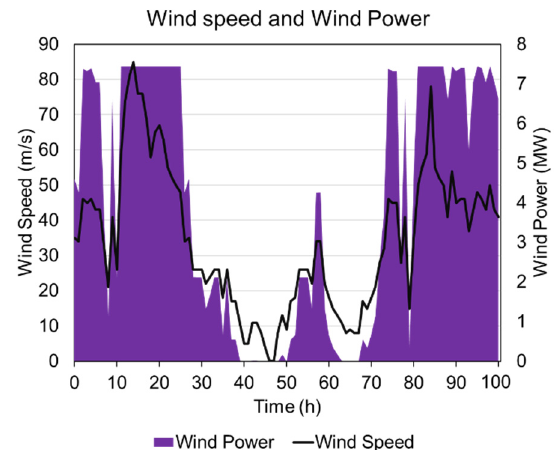
Figure 5. Wind speed and wind power change with time on the Sable Island in a 100 h duration.